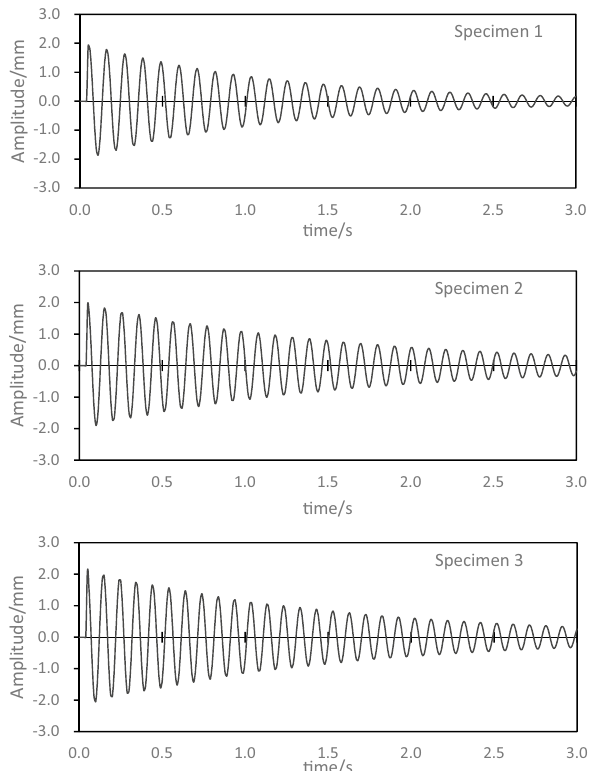
Figure 4. Damping experiment of samples with different fiber volume